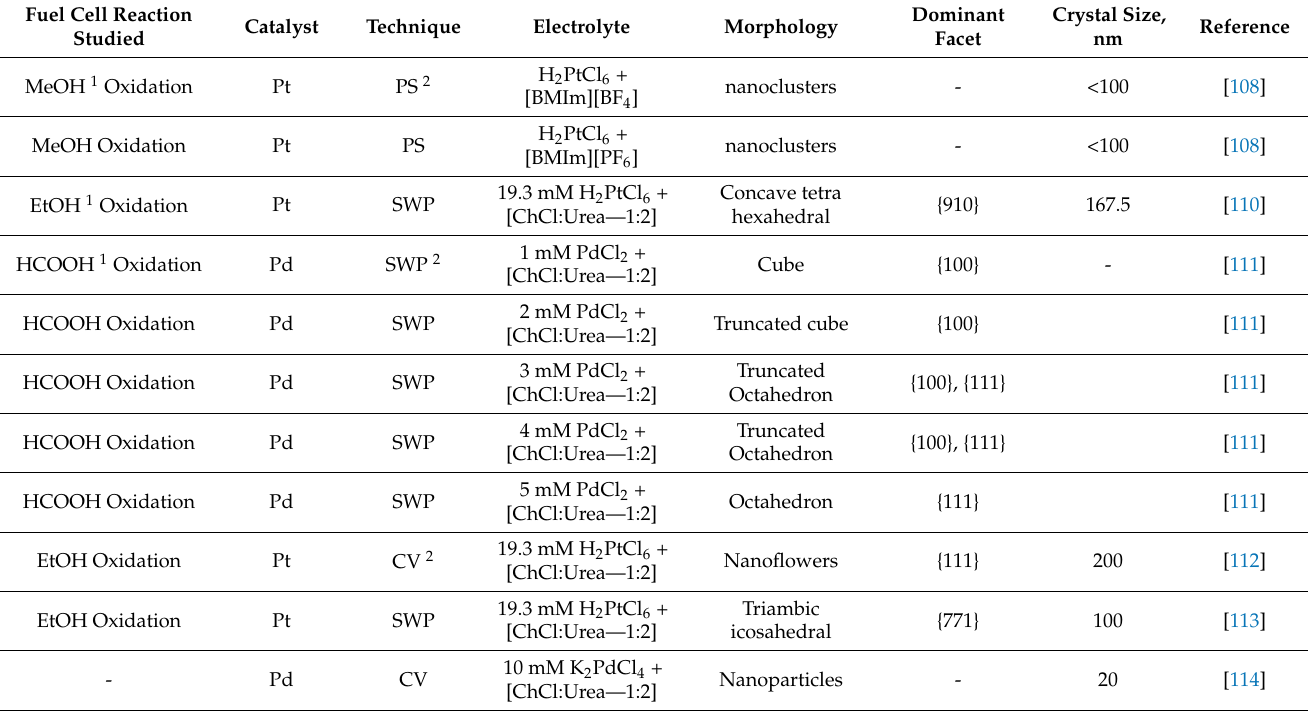
Table 5. Summary of the shape-controlled Pt and Pd catalysts that are obtained via electrodeposition employing ionic liquids and deep eutectic